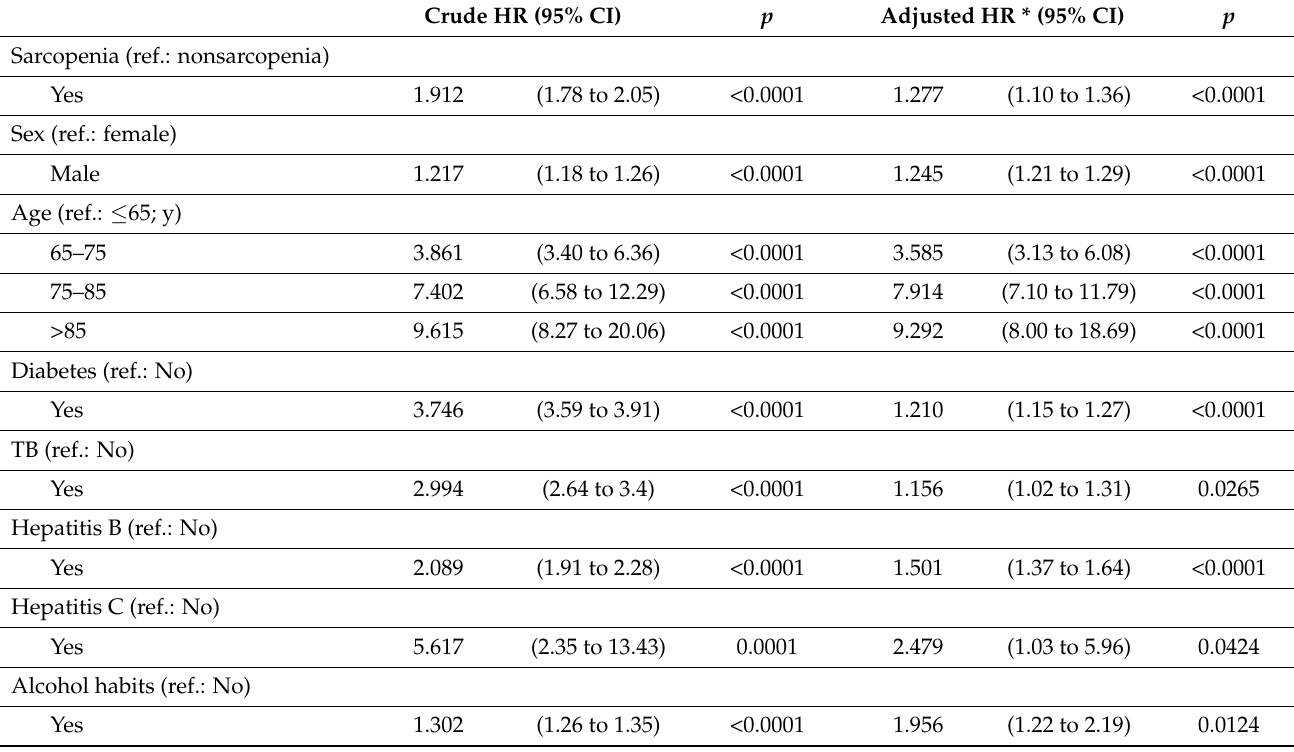
Table 2. Univariable and Multivariable Cox Proportional Regression Model for Cancer Risk in PS-Matched Patients with and Without Sarcopenia. (Only show statistical